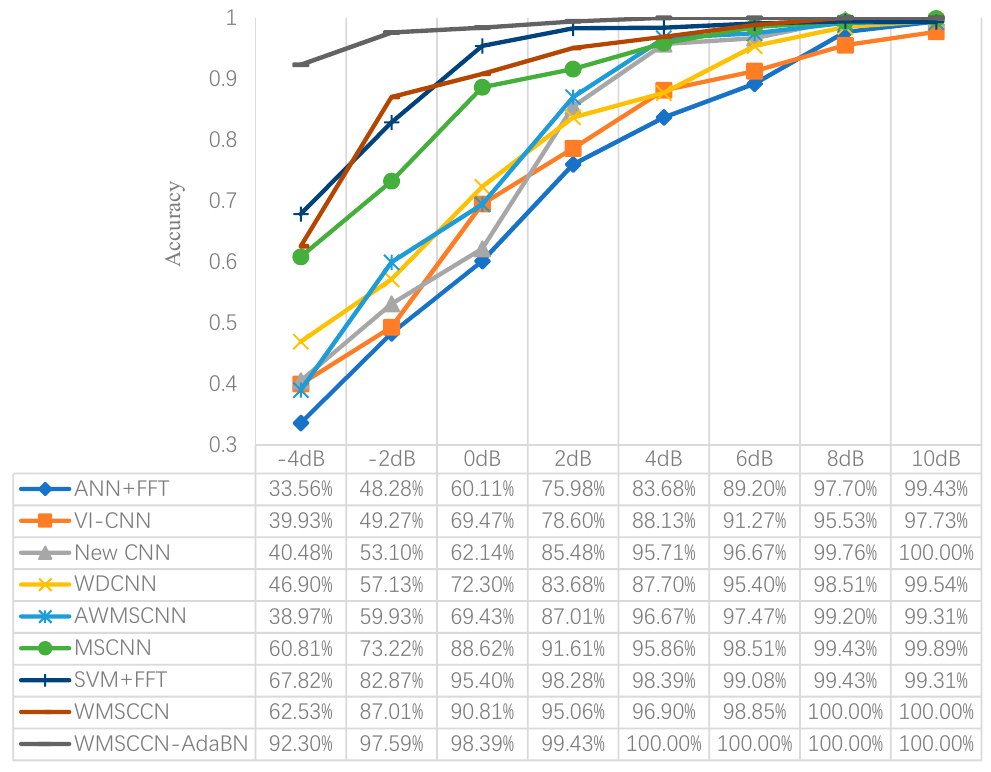
Figure 5. Comparison of diagnostic performance under different degrees of noise.